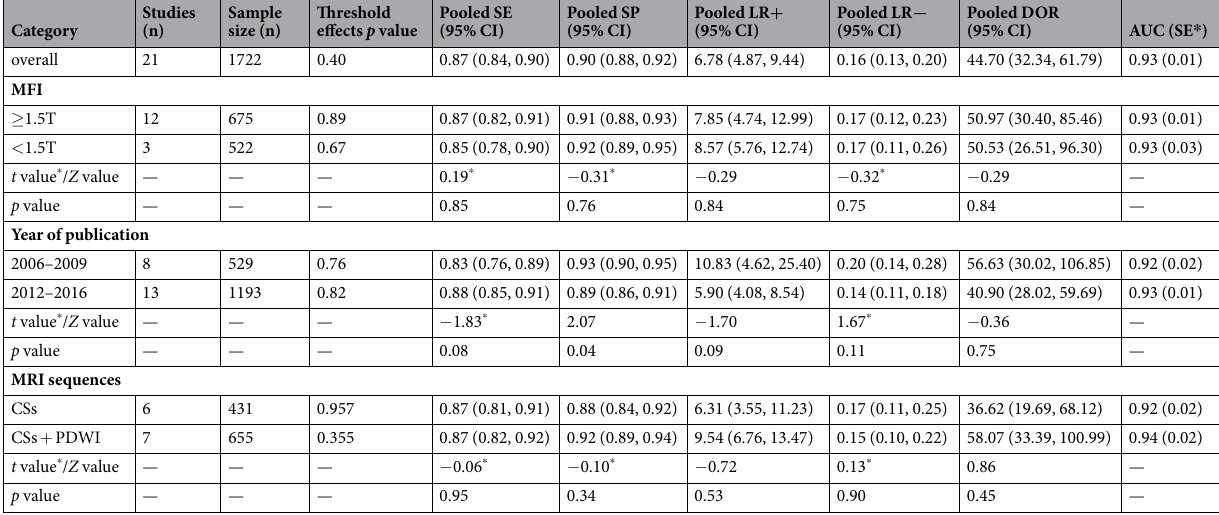
Table 2. Differences between subgroups according to MFI, year of publication and type of MRI sequence. SE: sensitivity; SP: specificity; LR + : positive likelihood ratios; LR − : negative likelihood ratios; DOR: diagnostic odds ratio; AUC: area under the curve; CI: confidence interval; SE * : standard error; MFI: magnetic field intensity; T: Tesla; MRI: magnetic resonance imaging; CSs: conventional sequences; PDWI: proton density weighted imaging; t : two independent samples t -test; Z: mann-whitney